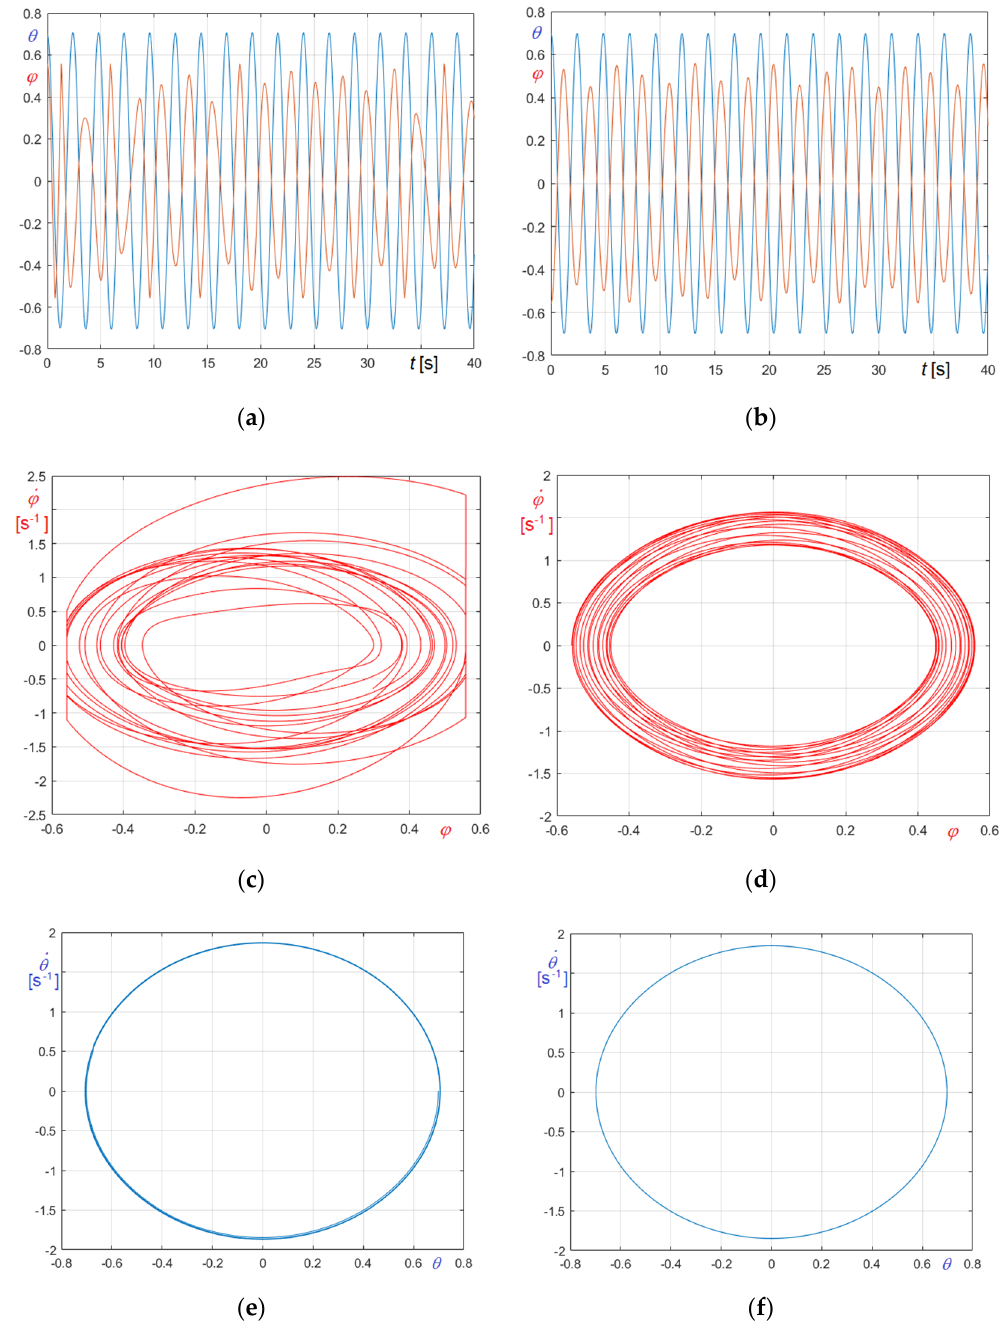
√ (cid:16) (cid:17) Figure 14. Undamped free oscillations of St. Mary’s tenor bell in case II (cid:3435)(cid:1837) = √0.2(cid:3439) : ( a ) (cid:2016) = (cid:2016)(cid:4666)(cid:1872)(cid:4667) and K = Figure 14. Undamped free oscillations of St. Mary’s tenor bell in case II 0.2 : ( a ) θ = θ ( t ) and ϕ = ϕ ( t ) curves for case II.a; ( b ) ) θ = θ ( t ) and ϕ = ϕ ( t ) curves for case II.b; ( c ) . ϕ − ϕ curves for case (cid:2030) = (cid:2030)(cid:4666)(cid:1872)(cid:4667) curves for case II.a; ( b ) ) (cid:2016) = (cid:2016)(cid:4666)(cid:1872)(cid:4667) and (cid:2030) = (cid:2030)(cid:4666)(cid:1872)(cid:4667) curves for case II.b; ( c ) (cid:2030)(cid:4662) − (cid:2030) curves for . . . ϕ − ϕ θ − θ curves for case II.a; ( f ) θ − θ curves for case case II.a; ( d ) (cid:2030)(cid:4662) − (cid:2030) curves for case II.b; ( e ) (cid:2016)(cid:4662) − (cid:2016) curves for case II.a; ( f ) (cid:2016)(cid:4662) − (cid:2016) curves for case II.b. II.a; ( d ) curves for case II.b; ( e )